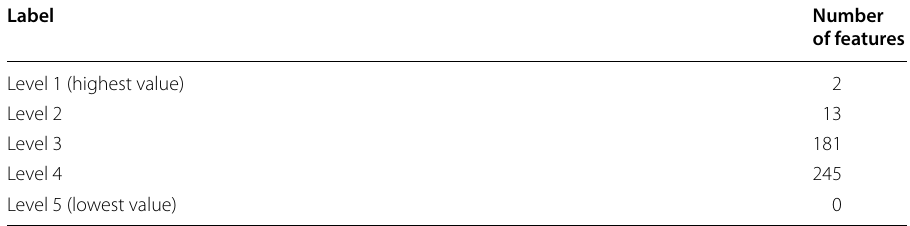
Table 6 Modified FIS results, using 3-level input membership function